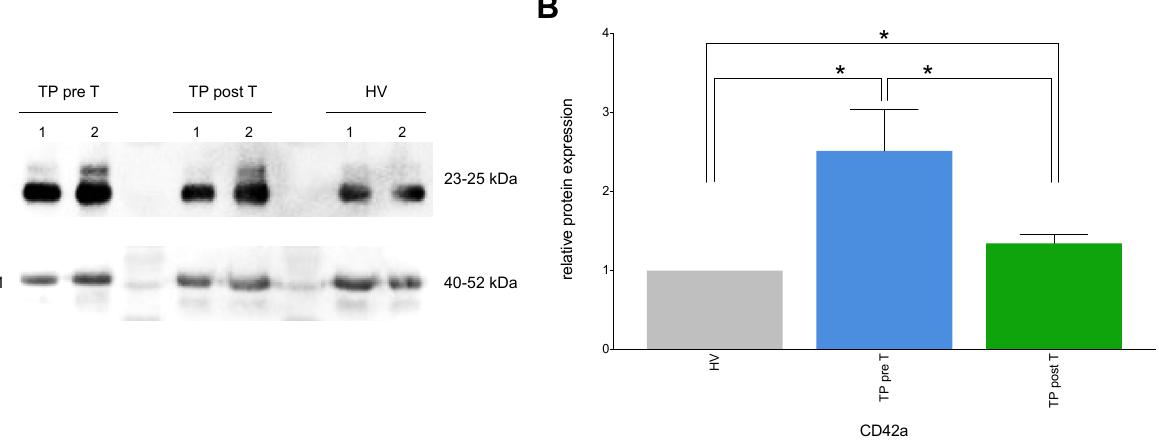
Figure 7. Representative protein expression of the cluster of differentiation (CD)42a and internal control TSG101 in western blot analysis ( A ), and relative changes in the protein expression levels of CD42a ( B ) in isolated EVs. The EVs derived from healthy volunteers (HV) and cholangiocellular carcinoma (CCA) tumor patients (TP) before (pre T) and after (post T) receiving a selective internal radiation therapy. The mean fluorescent intensity (MFI) is given as mean ± standard error of the mean. * p < 0.05 vs. indicated group.